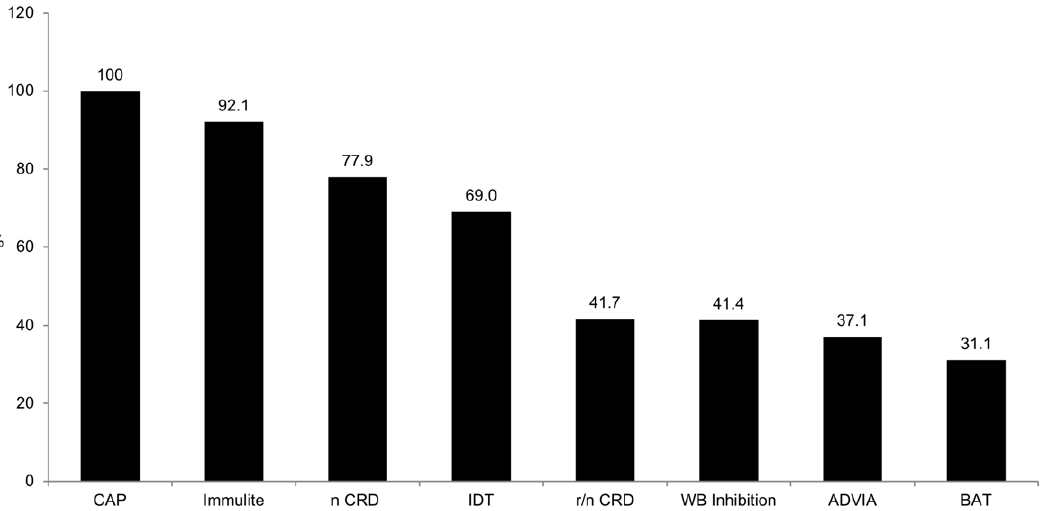
Figure 2. Frequency of double sensitization in supplemental tests in 72 CAP double positive patients. n CRD: native component resolved diagnosis with nApi m 1, nVes v 1, nVes v 5. r/n CRD: combined component resolved diagnosis with recombinant rApi m 1, and native nVes v 1, nVes v 5. BAT (p=0.324) and ADVIA (p=0.874) showed a similar frequency of DS compared to WB inhibition and r/n CRD, although they were performed with native venom